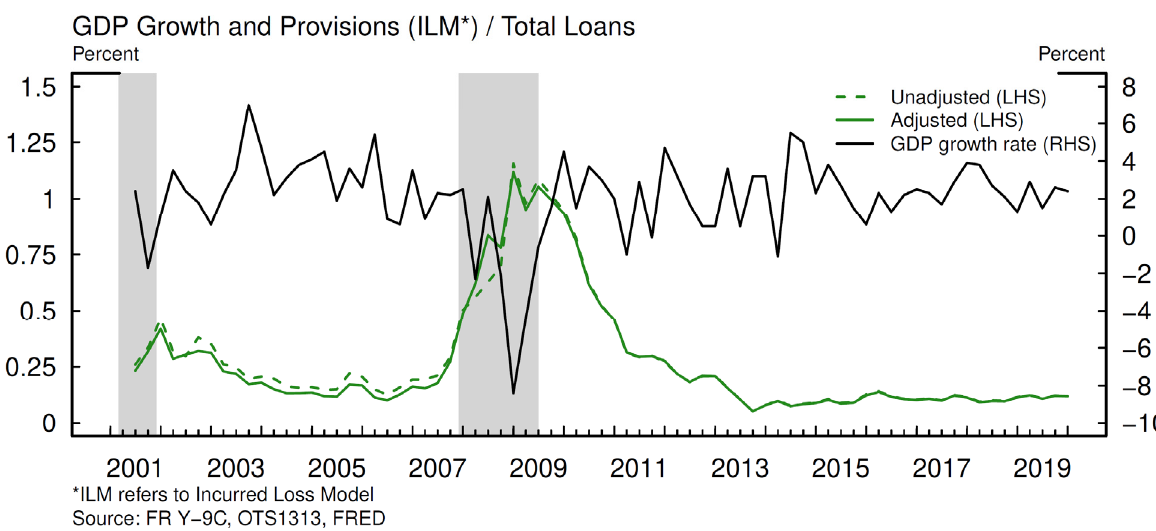
Figure 1. GDP growth compared to loan loss provisions/total loans (2000: Q1–2019: Q4, quarterly data).